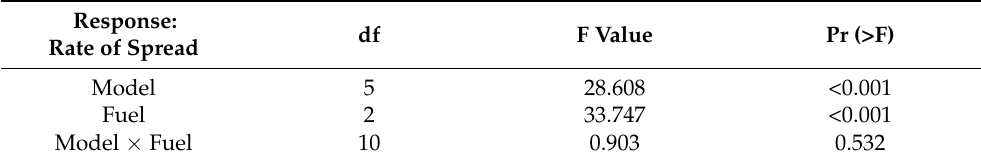
Table 3. ANOVA comparing the effects of the fire behaviour model (Model), fuel class (Low, Medium, or High load), and their interaction on rate of spread predictions using observed fuel structures. ‘df’ is n − 1 degrees of freedom. ‘F Value’ is the test statistic computed. ‘Pr (>F)’ is a significance value for each test set against α = 0.05. N = 27.